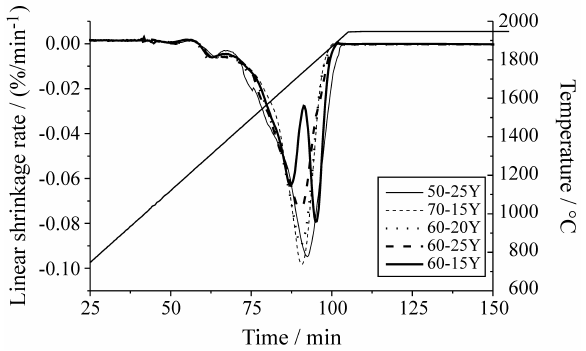
Fi gu re 6. Di la to me tric re sults: li ne ar shrin ka ge rate ver sus time for se ve ral com po si ti